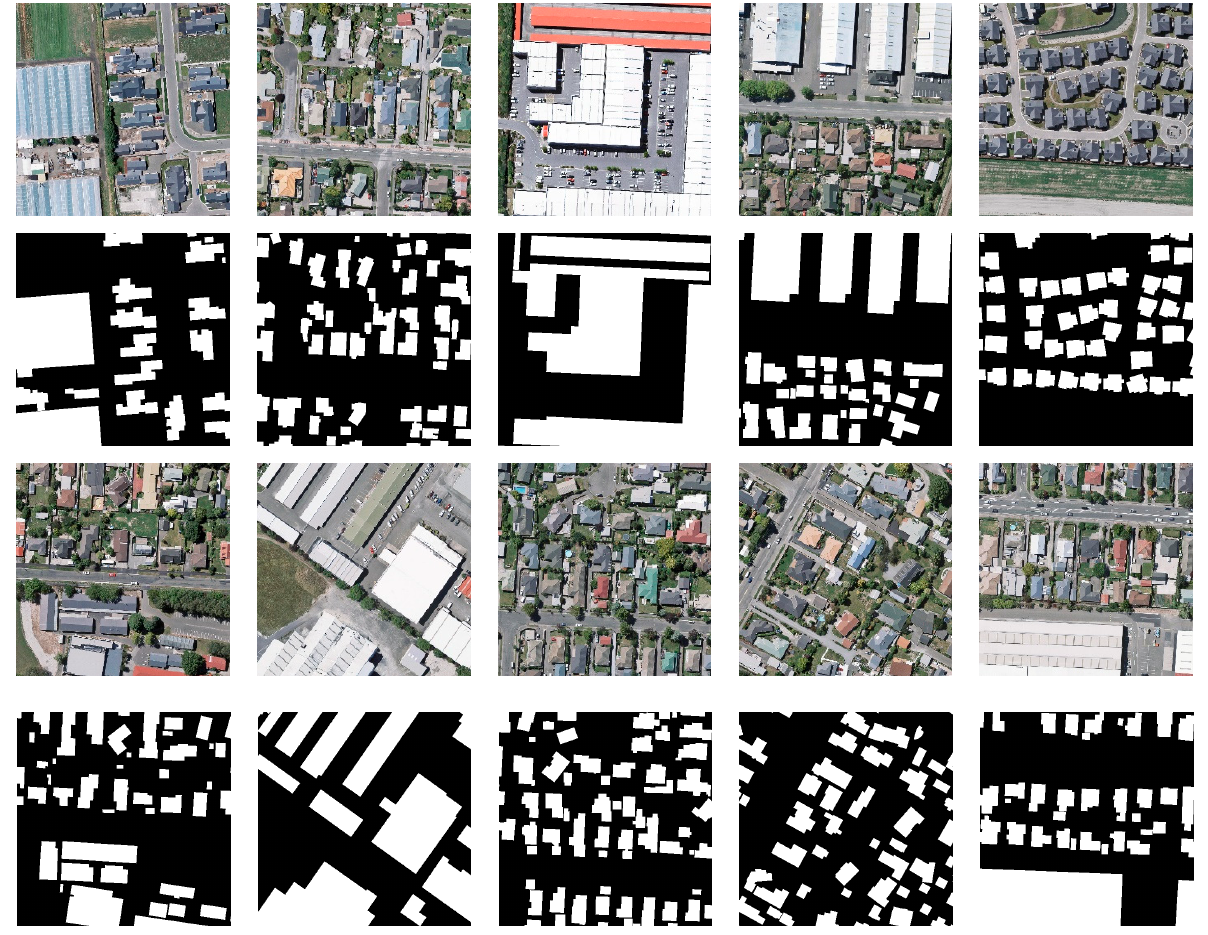
Figure 7. Samples of the WHU aerial image data set.